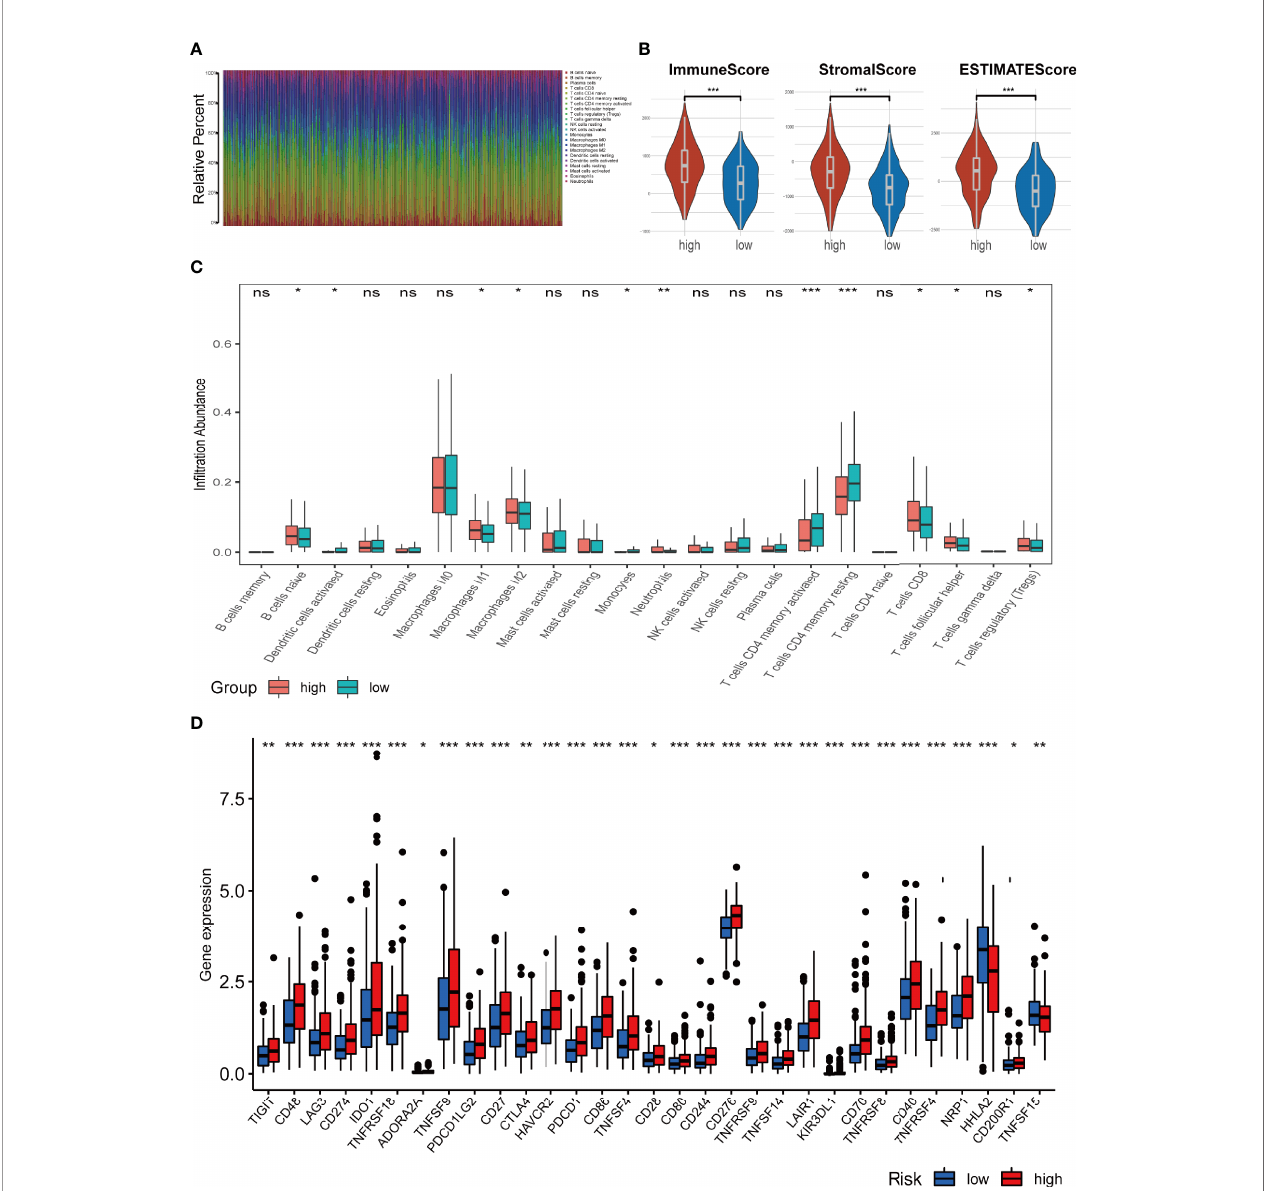
FIGURE 7 | Analysis of immune cell in fi ltration landscape in colon cancer patients. (A) Bar graphs exhibiting the distribution of tumour-in fi ltrating immune cells between the high-risk and low-risk groups based on the ferroptosis-related-lncRNAs signature. (B) Stroma, immune, and ESTIMATE scores in the high-risk and low- risk groups in colon cancer patients. (C) The boxplots for the comparison of the 22 immune cells between the high-risk and low-risk groups in the colon cancer patients. (D) The boxplots for the comparison of the immune checkpoints genes between the high-risk and low-risk groups in the colon cancer patients. *p < 0.05, **p < 0.01, and ***p < 0.001, ns, No signi fi